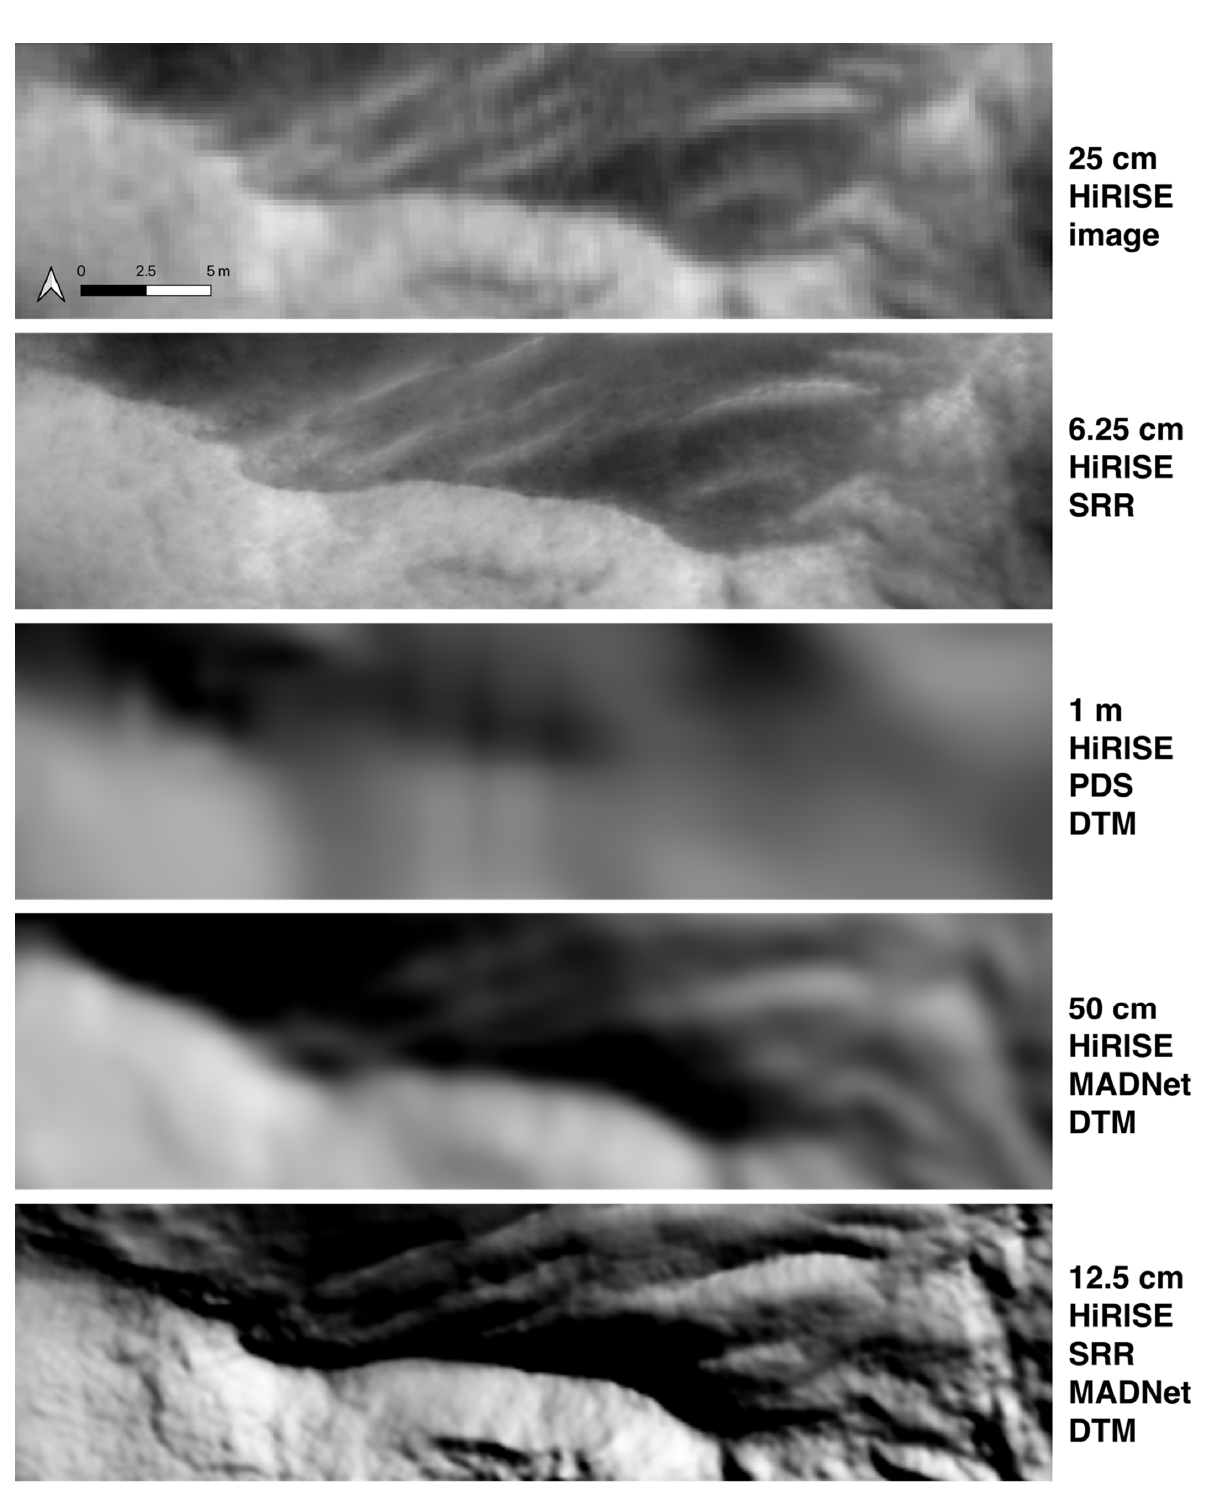
Figure 8. Visual comparisons of a small exemplar area (i.e., “Zoom-in Area-2”–a subarea of “Zoom-in Area-1” that is shown in Figure 7; location is shown in Figure 6) of the input 25 cm/pixel HiRISE PDS ORI (ESP_039299_1985_RED_A_01_ORTHO), the resultant 6.25 cm/pixel HiRISE SRR image, the shaded relief images (using similar illumination parameters as the HiRISE PDS ORI, i.e., 225° azimuth, 30° altitude, 2× vertical exaggeration) of the reference 1 m/pixel HiRISE PDS DTM (DTEEC_039299_1985_047501_1985_L01), the reference 50 cm/pixel HiRISE MADNet DTM, and the resultant 12.5 cm/pixel HiRISE SRR MADNet DTM (from top to